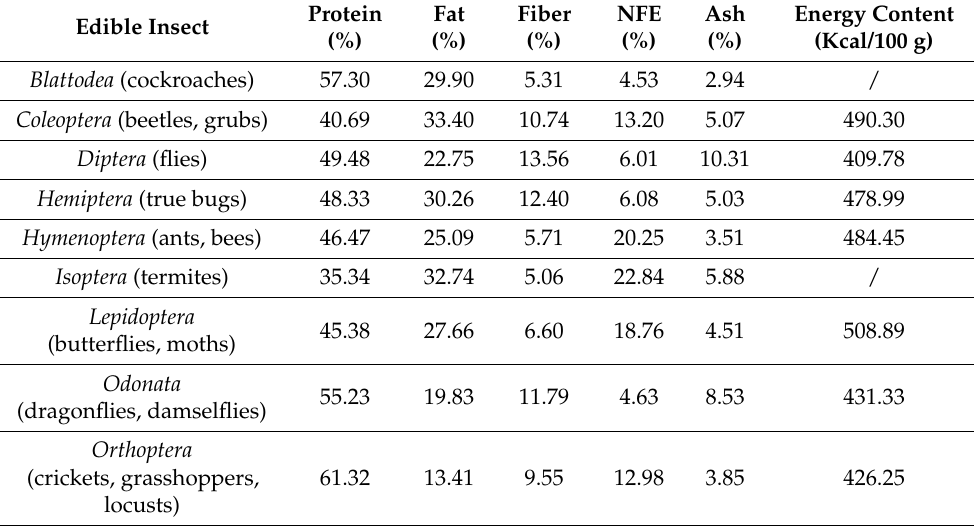
Table 1. Nutritional composition (%) and energy content (Kcal/100 g) of different orders of edible insects (dry